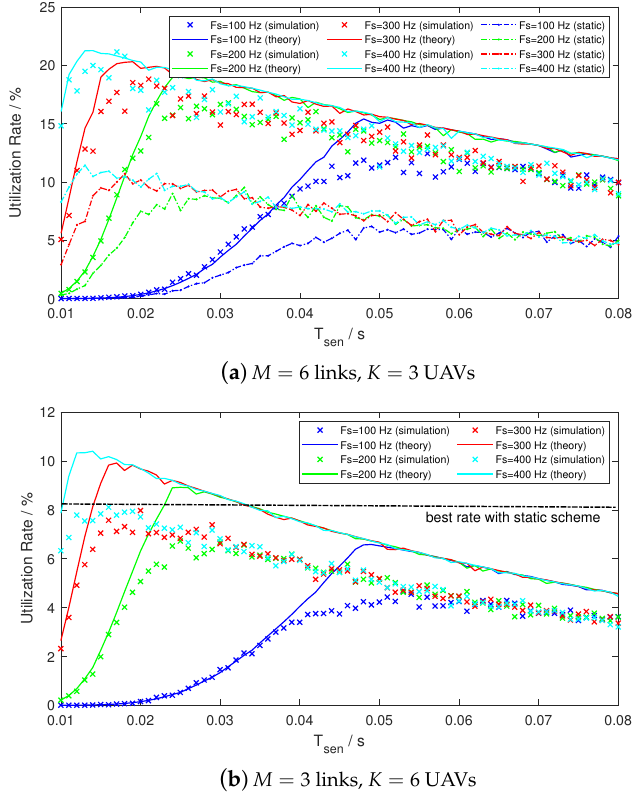
Figure 13. Utilization rate versus sensing time and F s when SNR =